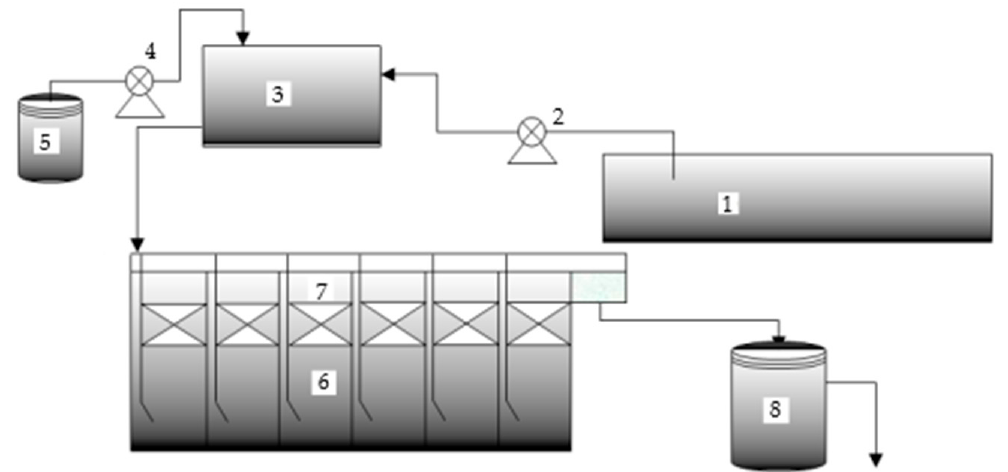
Figure 1. Flow chart of the hybrid anaerobic baffled reactor (HABR) reaction system. 1. coagulation sedimentation tank; 2. measuring pump; 3. inflow tank; 4. acid pump; 5. acid tank; 6. hybrid anaerobic baffled reactor; 7. cross ‐ flow packing; 8. catchment tank.